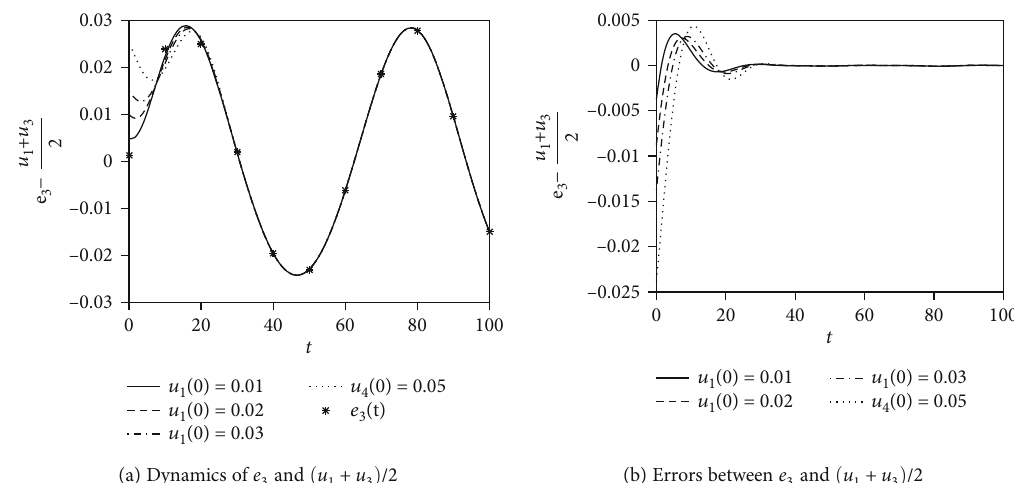
Figure 3: The comparison between numerical and analytical results of synchronous dynamics e ω = 0 : 1 for di ff erent initial conditions. (a) The synchronization dynamics of e initial conditions are u